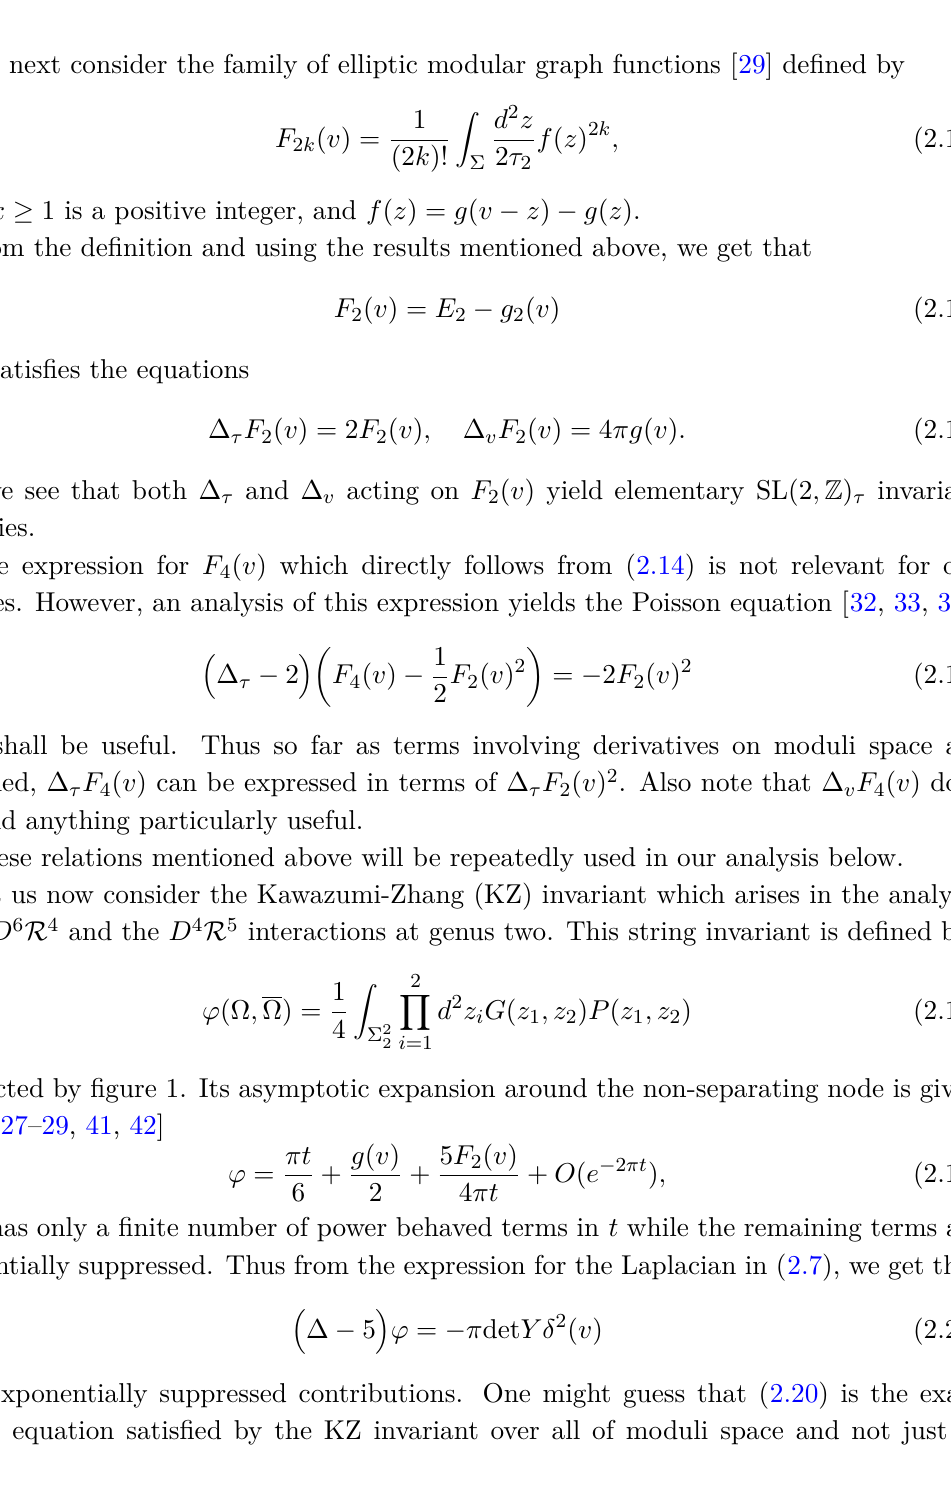
Figure 1 . The string invariant ϕ